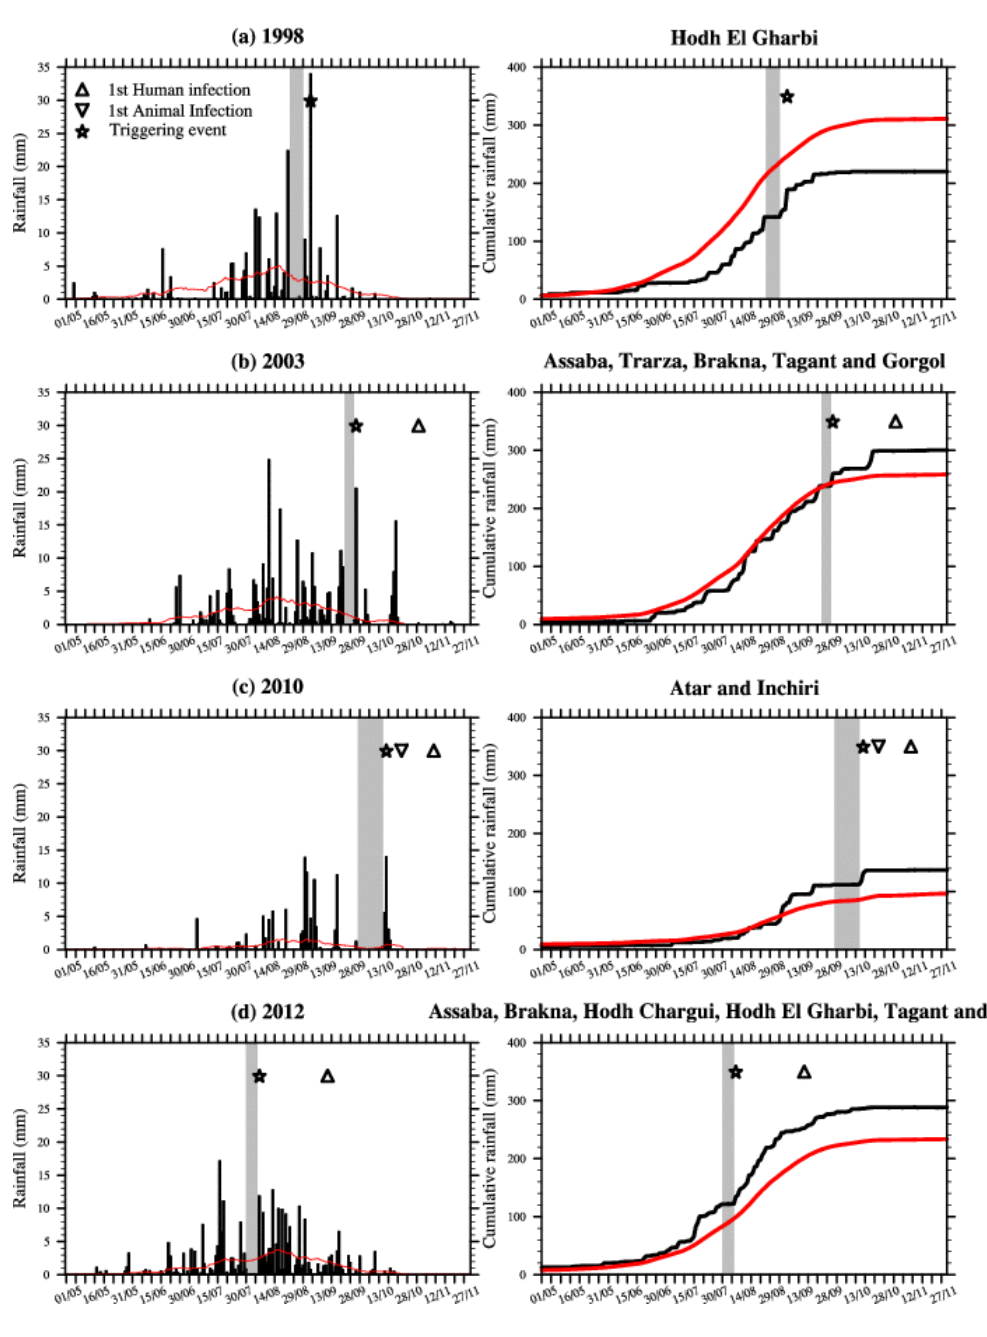
Figure 2. Rainfall indices (mm) averaged over ( a ) 15.5°N–17.5°N, 11°W–8.5°W in 1998, ( b ) 15.5°N–19°N, 16.25°W–11°W in 2003, ( c ) 19°N–21°N, 14.75°W–12.75°W in 2010 and ( d ) 15.5°N–19.25°N, 15.85°W–6.5°W in 2012. This is based on the TRMM rainfall dataset; see Figure 1 for a definition of the domains covering the RVF outbreak locations. Right: Cumulative rainfall (mm) for the same areas. The red line depicts the rainfall climatology (1998–2012) calculated for the respective areas. Dry spells are highlighted by the gray shading, large rainfall event are shown with stars and the first human and animal RVF reported cases are depicted by